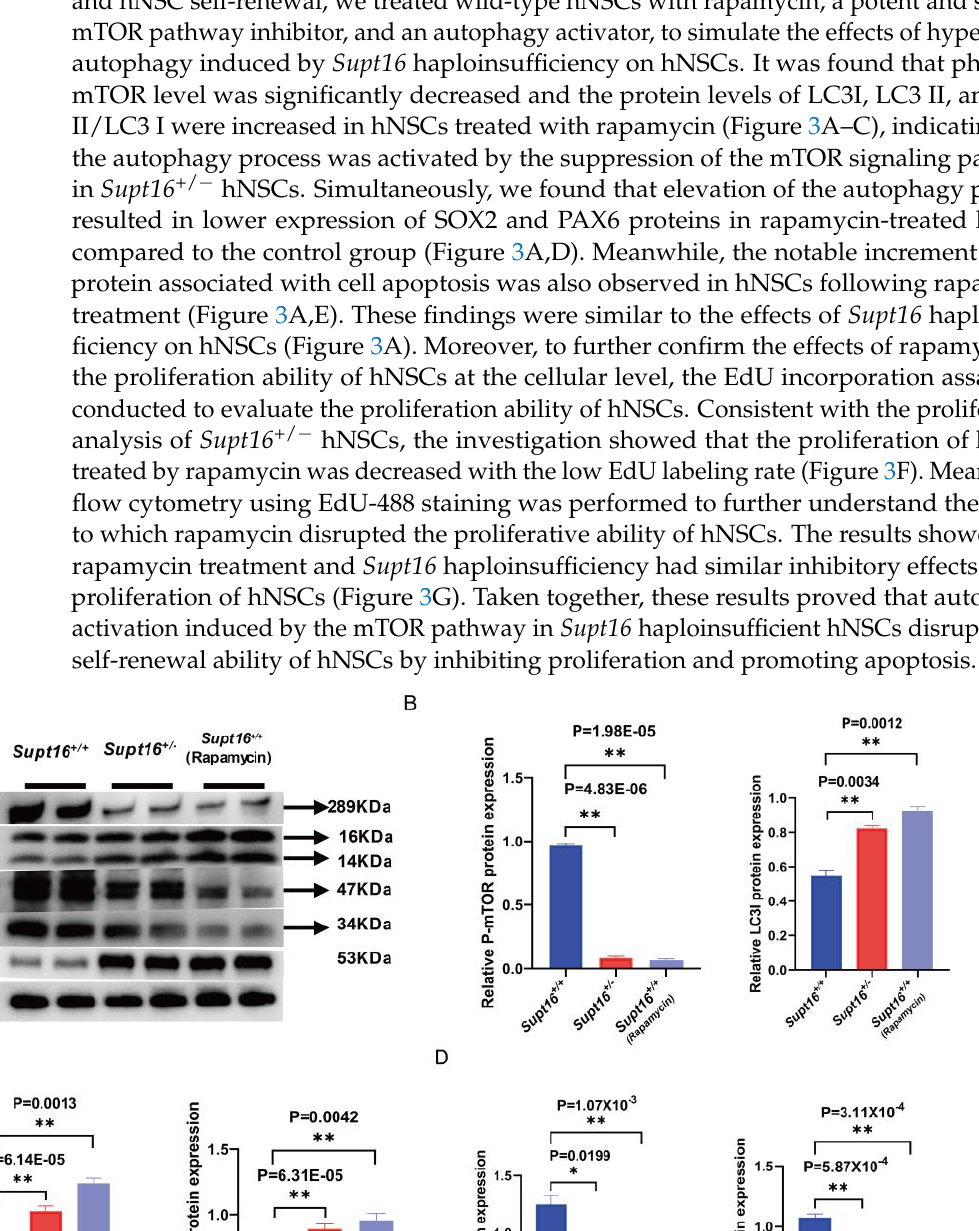
Figure 3. Wild − type hNSCs treated by rapamycin reproduced the phenotype of Supt16 haploinsufficient hNSCs . ( A ) Western blot analysis showing P − mTOR, LC3, PAX6, SOX2, and P53 protein expression in hNSCs treated with different treatments ( n = 3). ( B ) Quantification analysis of P − mTOR, LC3I protein relative to GAPDH. Data are means ± standard deviation of three independent experiments. ( C ) Quantification analysis of LC3II and LC3II/LC3I protein relative to GAPDH. Data are means ± standard deviation of three independent experiments. ( D ) Quantification